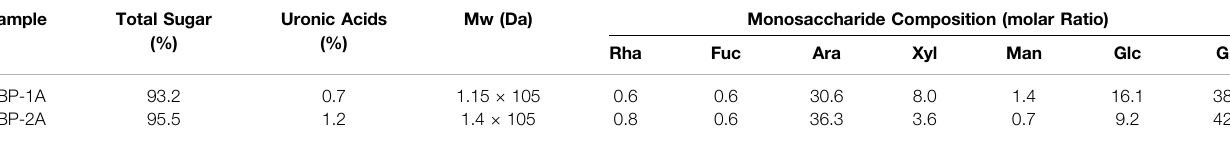
TABLE 3 | Preliminary characterization of SBP-1A and